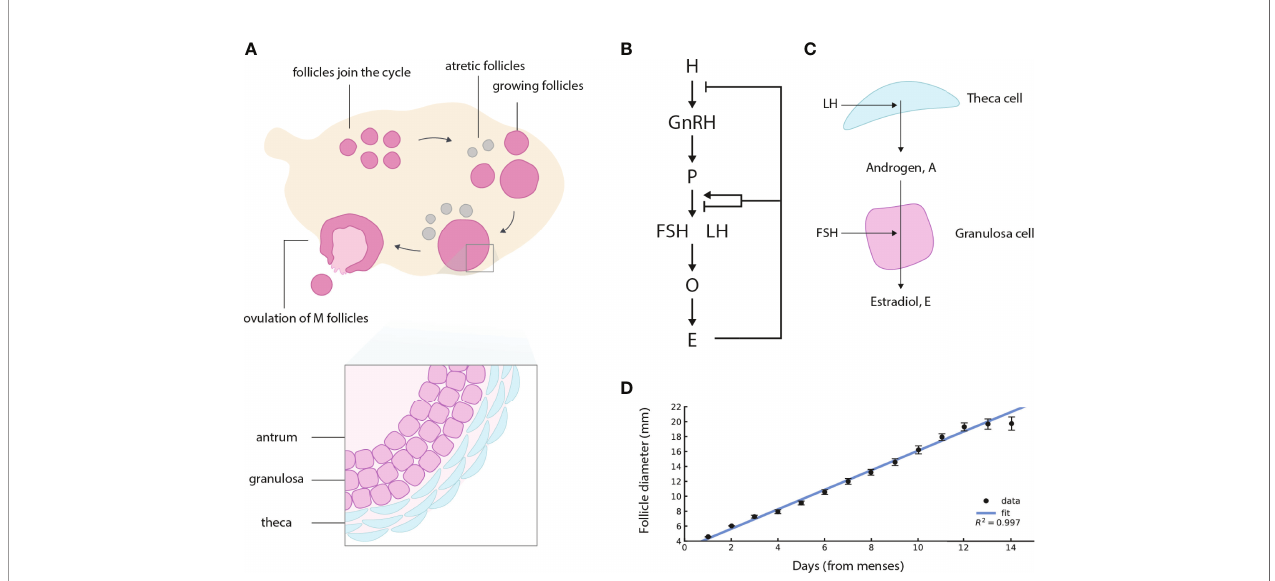
FIGURE 1 | Ovarian follicles compete for ovulation during the follicular phase of the menstrual cycle, under control of the Hypothalamus-Pituitary-Ovary (HPO) axis. (A) Follicles join the menstrual cycle and grow, M of them “ win the race ” and ovulate, and the rest die (atretic follicles). In this schematic fi gure, M = 1 is shown. (B) The HPO axis controls circulating hormone levels. H denotes hypothalamus, P pituitary, O ovaries (speci fi cally the ovarian follicles), and E estradiol. Estradiol control of gonadotropin production changes sign from negative to positive at high sustained estradiol levels. (C) Follicles in the ovary produce steroid hormones. LH induces theca cells to convert cholesterol to androgen. Most of the androgen goes to the circulation, and a small amount is converted to estrogen by the granulosa cells under control of FSH. (D) The dominant human follicle size measured by ultrasound grows with an approximately constant velocity (linear growth) in the follicular phase, adapted from (1). Regression line for the fi rst 13 days of the follicular phase is shown, after which the control of Estradiol changes